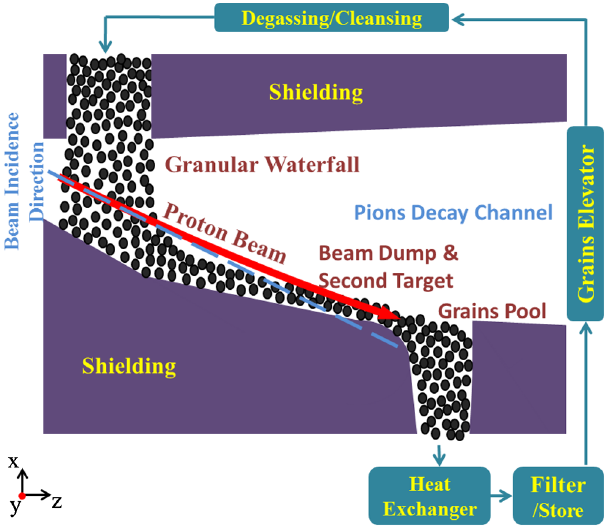
FIG. 1. Schematic outline of a granular waterfall target in the grain loop system with heat exchanger, grain filter, lift, and degassing/cleansing devices.